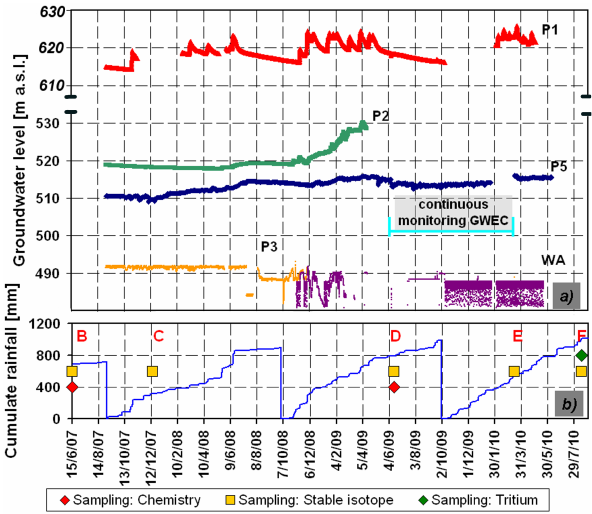
Fig. 3. (a) Continuous groundwater level (GW L ) monitoring for piezometers P1, P2, P3, P5 and drainage well WA. (b) Cumula- tive rainfall for each hydrologic year. Chemical (red square) and isotopic (yellow diamond: stable isotopes; green diamond: tritium) sampling campaigns are